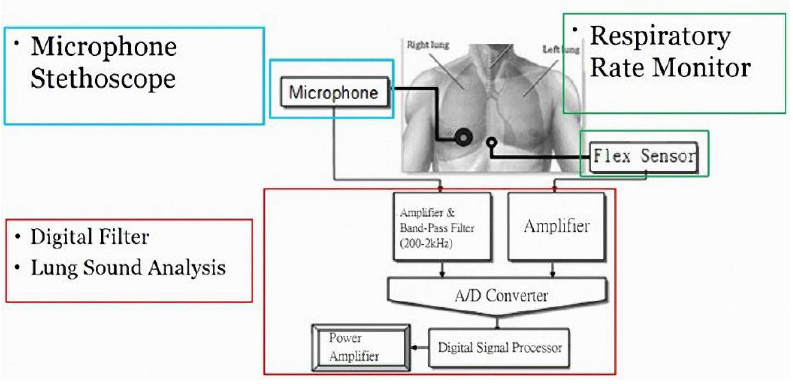
Figure 2. System